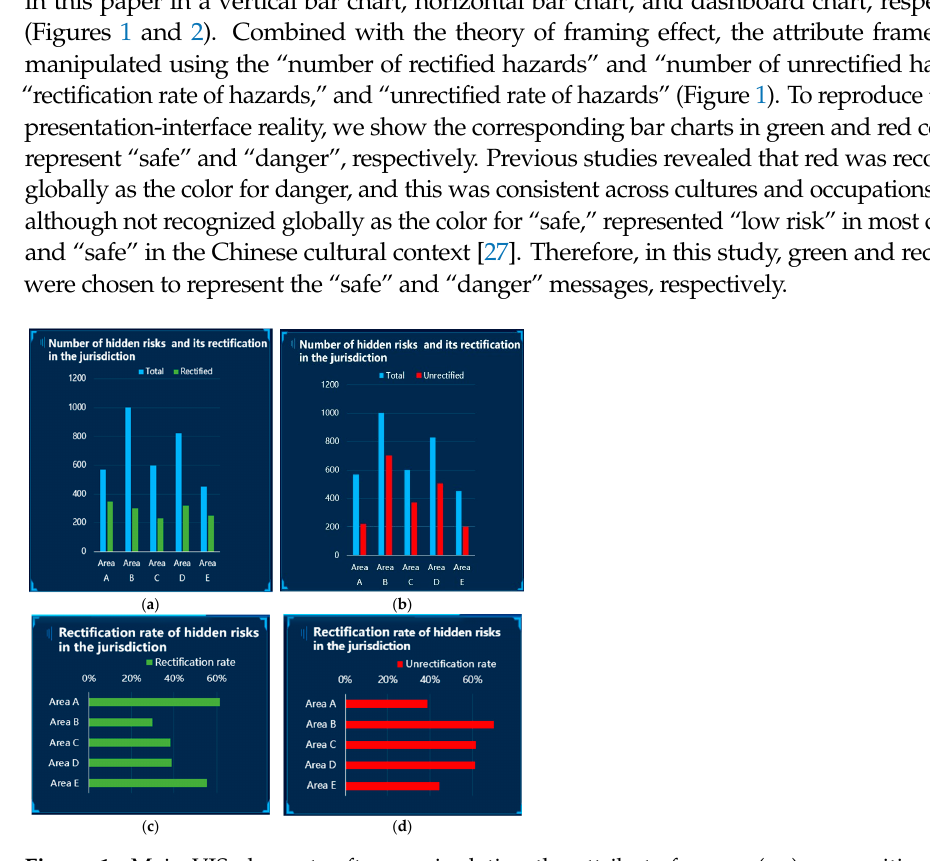
Figure 1. Main VIS elements after manipulating the attribute frames: ( a , c ) are positive frames; ( b , d ) are negative frames.